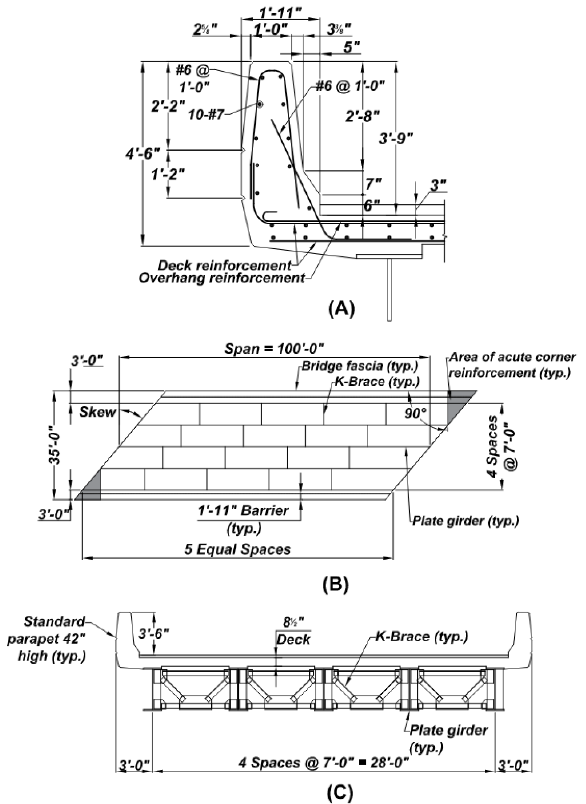
Figure 4. The standard details from the prototype bridge models including the ( A ) parapet, ( B ) general framing plan and ( C ) typical section.